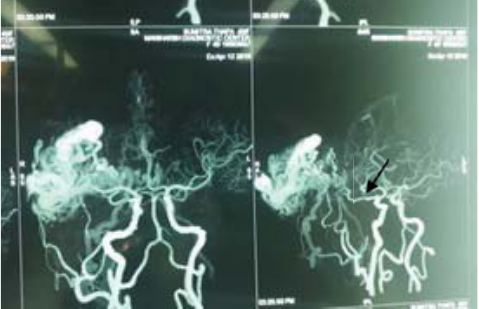
Figure 2. CT angiography demonstrating large vascular nidus with multiple arteries feeders, predominantly supplied by right ophthalmic artery (black arrow).